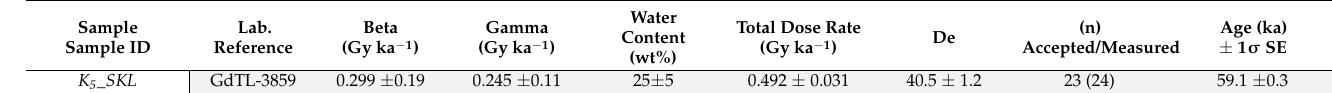
Table 1. Results and details of OSL dating. Equivalent dose values were determined using the central age model (CAM) of Galbraith et al. [30]. Water content expressed as a percentage of the mass of dry sediment, calculated using field values. Beta, gamma, and cosmic dose rates were combined to calculate the total dose rates after Aitken [60]. Beta and gamma dose rates were calculated using the conversion factors of Liritzis et al. [61]. Beta dose rates have been corrected for the effect of the water content, grain size, and chemical etching. Gamma dose rates have been corrected for the effect of the water content. Cosmic dose rates were calculated according to [62,63]. Age, before 2016